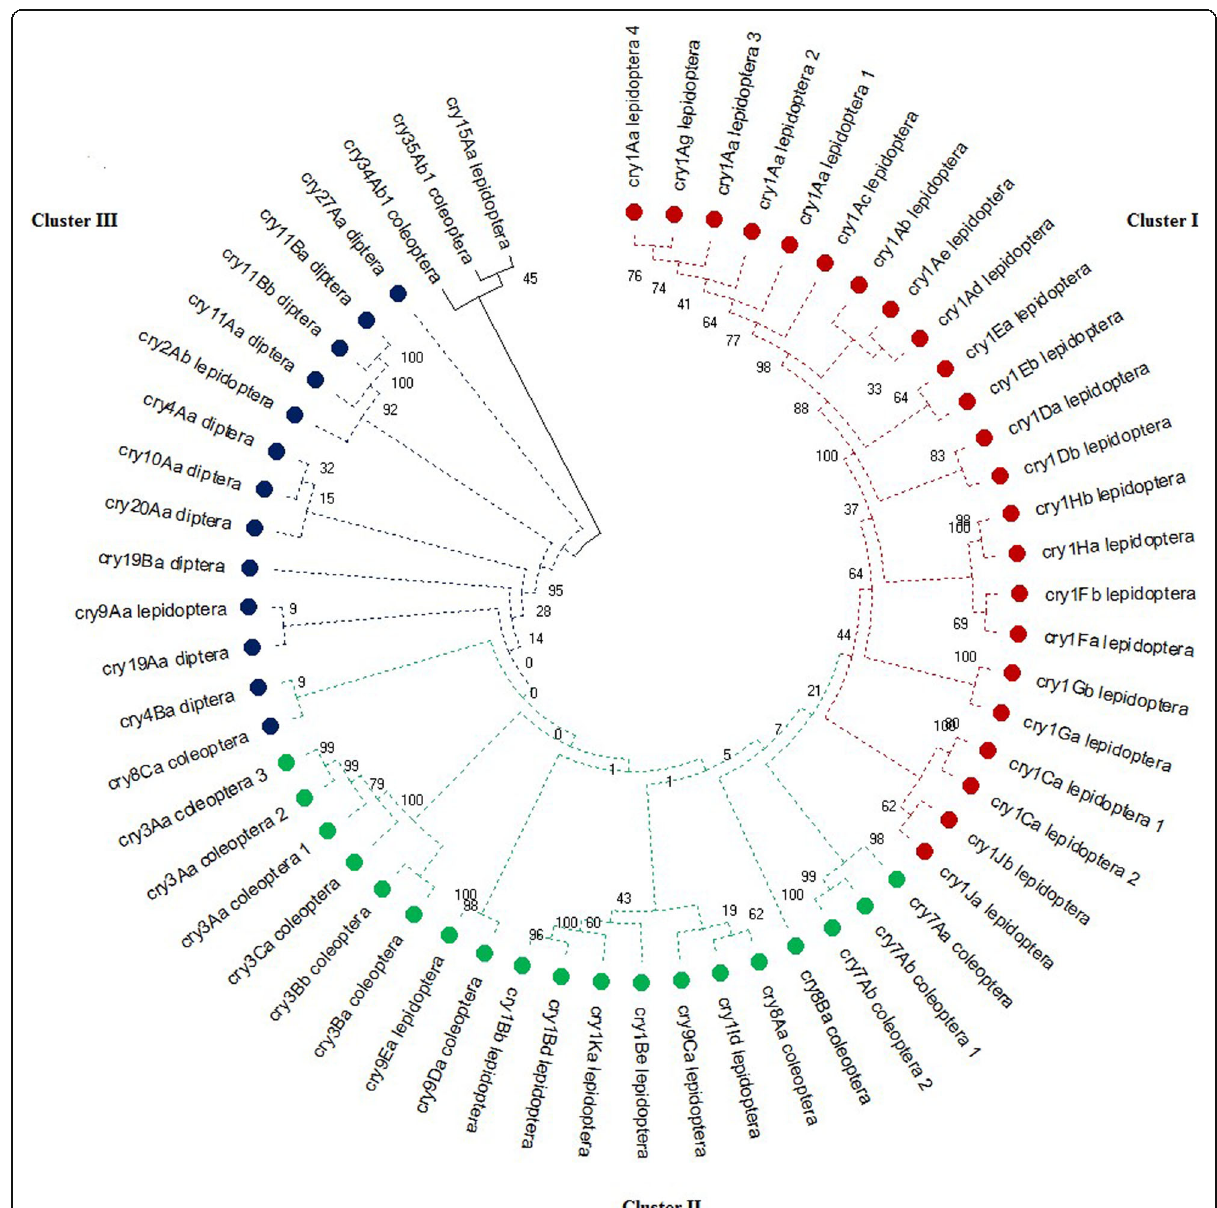
Fig. 3 Phylogenetic tree using MEGA X showing 58 numbers of cry proteins having toxicity for three insect